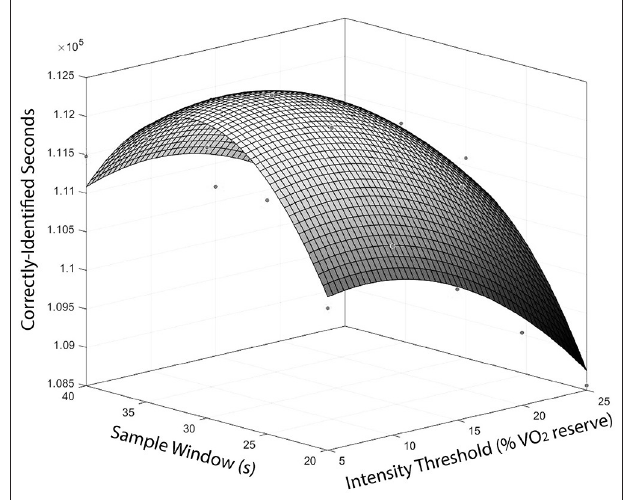
FIGURE 1 | Surface function representing the number of correctly-identified seconds by the automated method compared to the manual method for different combinations of sample window and intensity